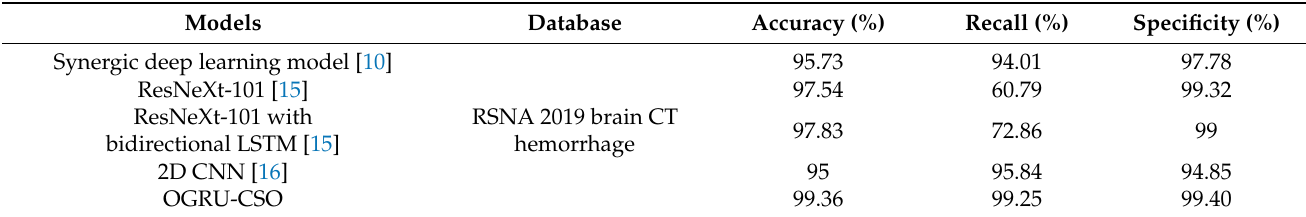
Table 7. Comparative investigation between the proposed and the existing